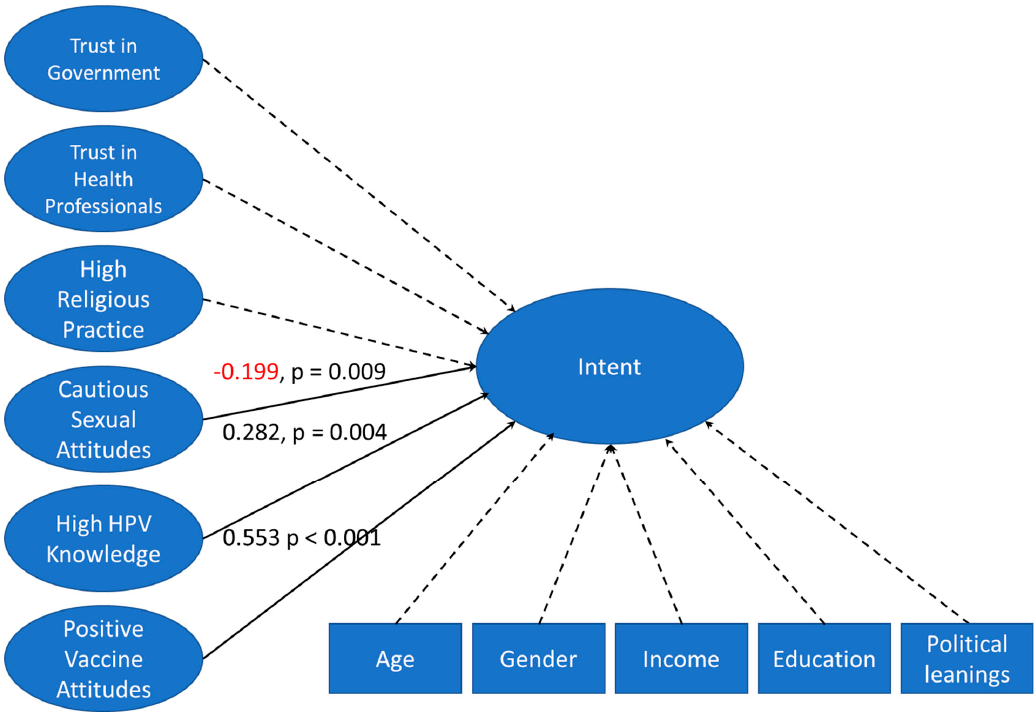
Figure 3. Full structural model: Latent variables and covariates were combined into a full structural model. Structural equation modeling was performed to determine which factors impact parental intent to vaccinate their children against HPV. More cautious sexual attitudes lead to lower intent. Higher knowledge about HPV leads to higher intent to vaccinate. The more positively parents view vaccines the higher their intent to vaccinate their children against HPV. All other latent variables and covariates were not significantly predictive of intent to vaccinate in the full structural model. Values are beta coefficients. Value in red shows negative correlation. SEM on model A shows a robust fit, as indicated by fit statistics (Table 3). The model (Figure 4) indicates that high trust in health professionals leads to more positive vaccine attitudes (+0.620) which increases intent to vaccinate (+0.665). The indirect effect through positive vaccine attitudes explains 96% of the effect of trust in health professionals on in- tent to vaccinate. High religious practice does not affect general vaccine attitudes in this model, but it does have a negative impact on intent to vaccinate against HPV. This